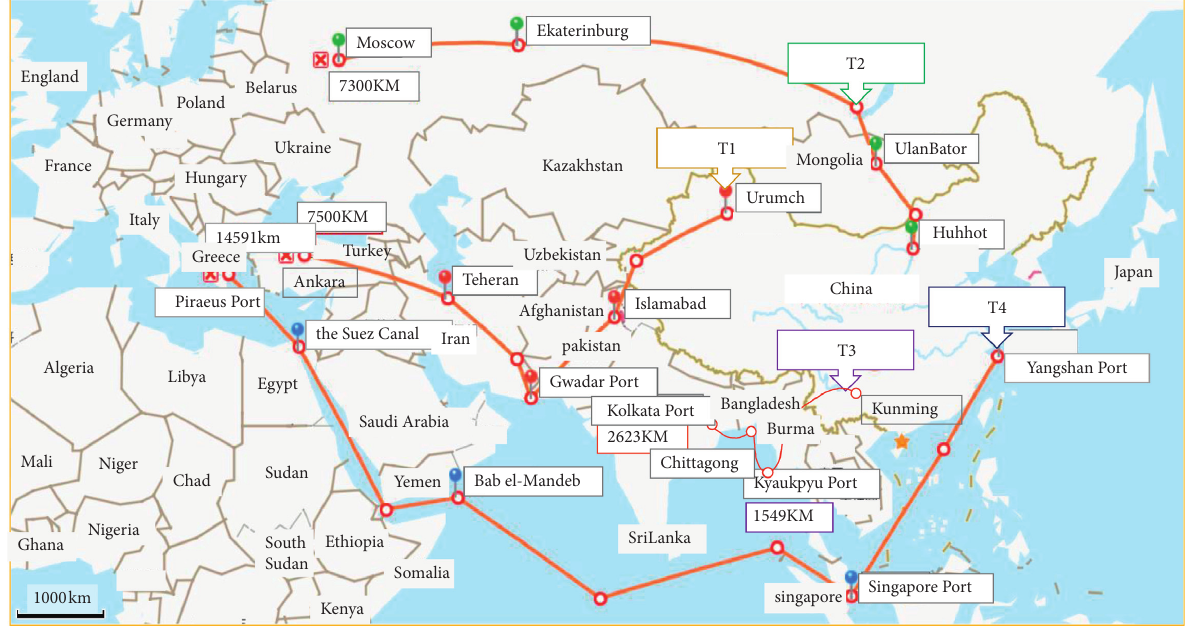
Figure 3: Corridors orientation roadmap of T1, T2, T3, and T4.